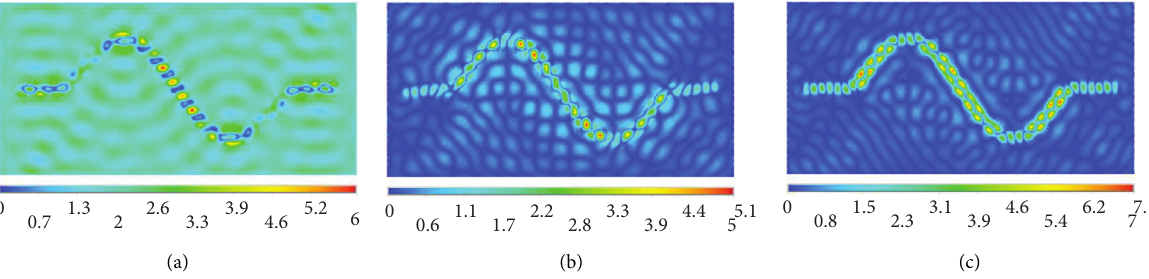
Figure 18: SV wave incident ( f � 3.0Hz, H � 100m, C